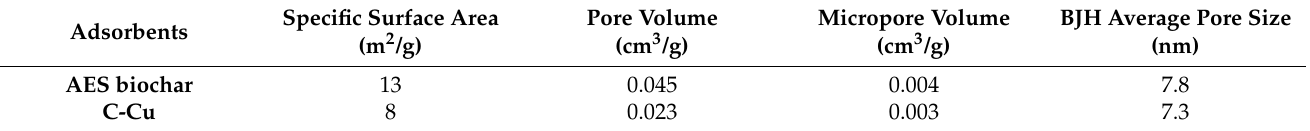
Table 1. Specific surface area, pore volume, and pore size values of AES biochar and C-Cu.